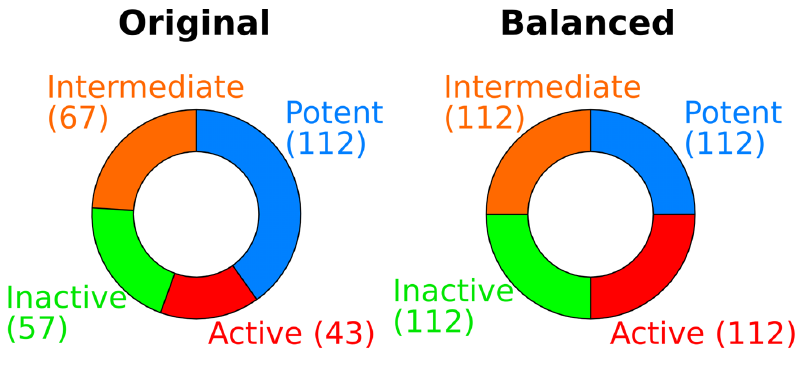
Figure 8. Frequency of bioactivity of 279 steroidal inhibitors. Using random oversampling strategies for data balancing, there were 448 datasets in total. The 448 datasets are the results of the random duplication of the three minor classes (active, intermediate, and inactive class) to match with major class (potent class).